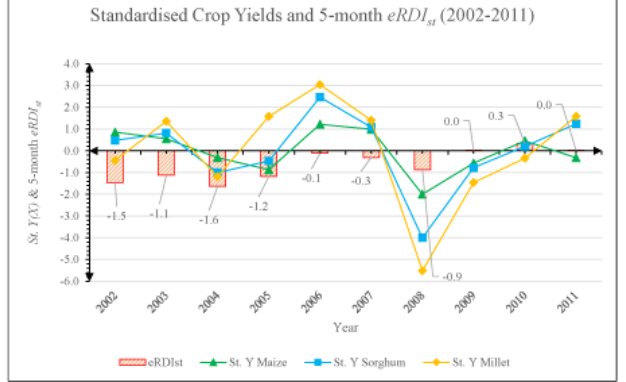
Figure 4: Plot of Standardised Crop Yields & 5-month eRDIst depicting how crop yields show a decreasing trend when effective rainfall reduces i.e. 5-month eRDIst values decreasing from one season to another while crop yields increase when the 5-month eRDIst values increase from one season to